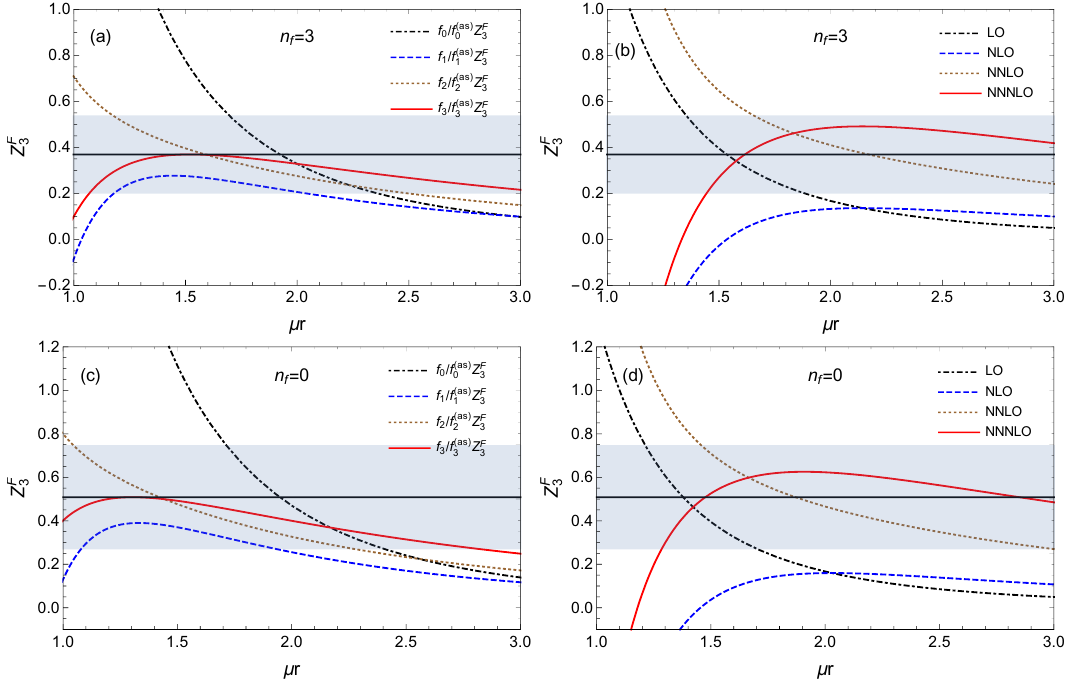
Figure 1 . Left (cid:12)gures . Determination of Z F values of n in the MS scheme. Right (cid:12)gures . Determination of Z F